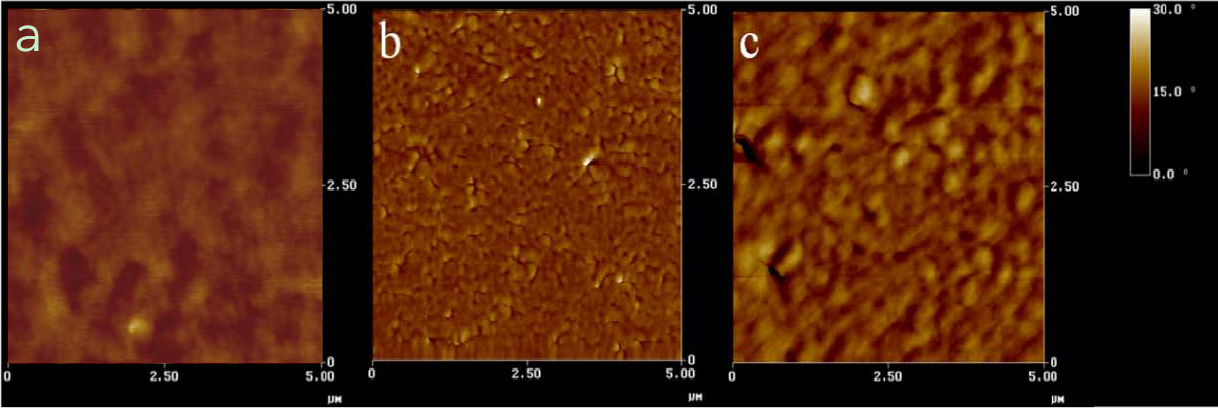
Figure 3. AFM phase images of samples ( a ) gPU. ( b ) gPUPB2. ( c ) gPUPB4. The contrast covers phase variations in 0°–30° range.